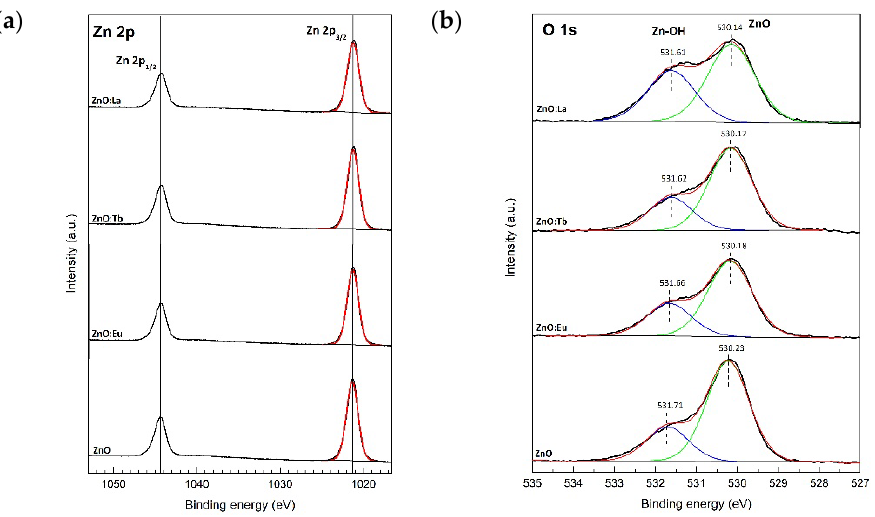
High resolution XPS spectra of Zn 2p and O 1s are depicted in Figure 5. The double peaks at 1021.3 and 1044.3 correspond to Zn 2p 3/2 and 2p 1/2 core-level photoelectron lines, respectively. The HRXPS spectra of O 1s exhibit a dominant emission at 530.2 eV, due to bulk oxygen in ZnO wurtzite structure, accompanied by a high energy shoulder at 531.6 eV, ascribed to oxygen from hydroxyl groups (Zn-OH) on Zn-polar (0001) or O-polar (0001) faces [33].